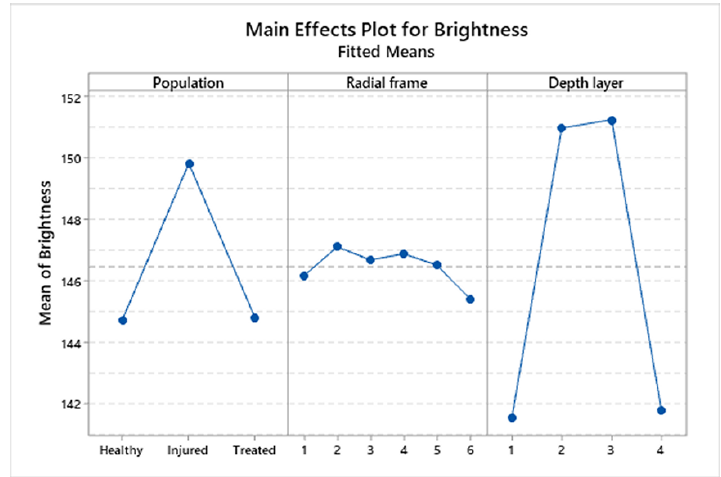
Figure 8. Main effects plot for brightness graphically representing the estimated fixed effect due to Figure 8. Main e ff ects plot for brightness graphically representing the estimated fixed e ff ect due to population, radial frame and depth layer. population, radial frame and depth